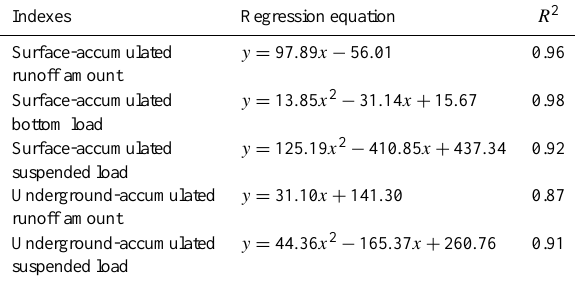
Table 3. Regression equation of accumulated runoff and sediment production and rainfall intensity ( x